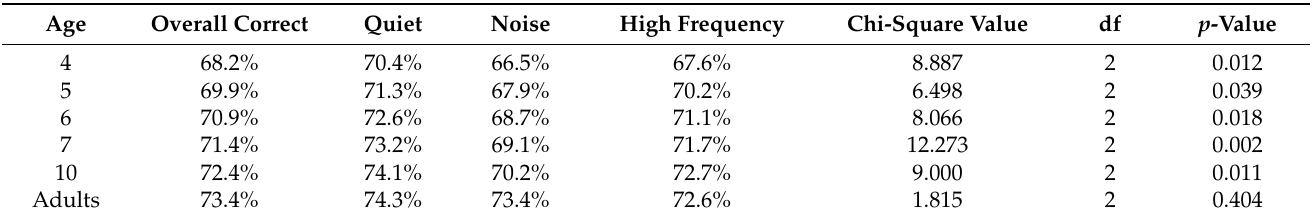
Table 4. Percentage of correct responses for AAST in quiet, noise and high frequency settings according to